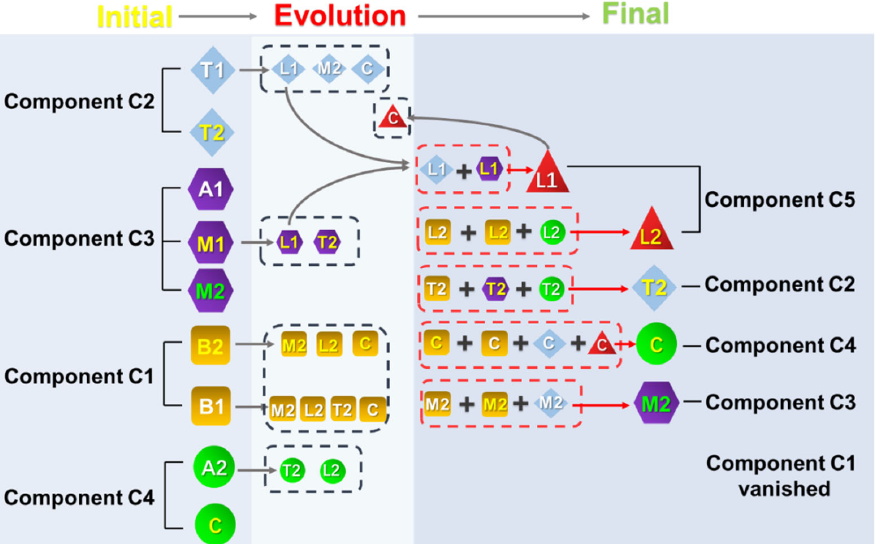
Figure 5. The dynamic of fluorescence molecules during composting was proposed by analyzing the 2DCOS and hetero ‐ 2DCOS among the excitation loadings of molecules.